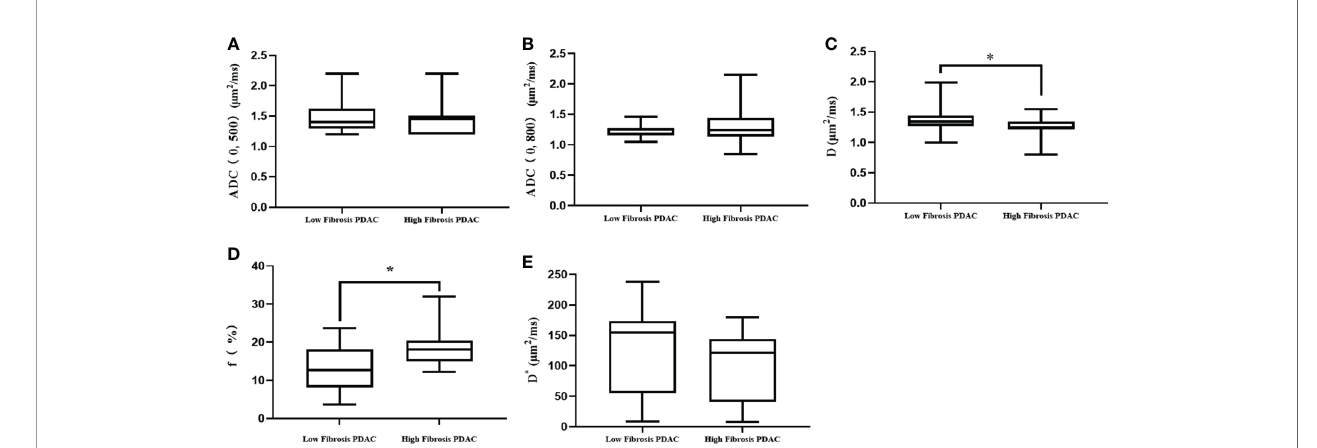
FIGURE 4 | Comparison of DWI parameters between high- and low- fi brosis PDAC. (A) The comparison of ADC (0, 500) values between low- and high- fi brosis PDAC. (B) The comparison of ADC (0, 800) values between low- and high- fi brosis PDAC. (C) The comparison of D values between low- and high- fi brosis PDAC. (D) The comparison of f values between low- and high- fi brosis PDAC. (E) The comparison of D* values between low- and high- fi brosis PDAC. *P < 0.05.